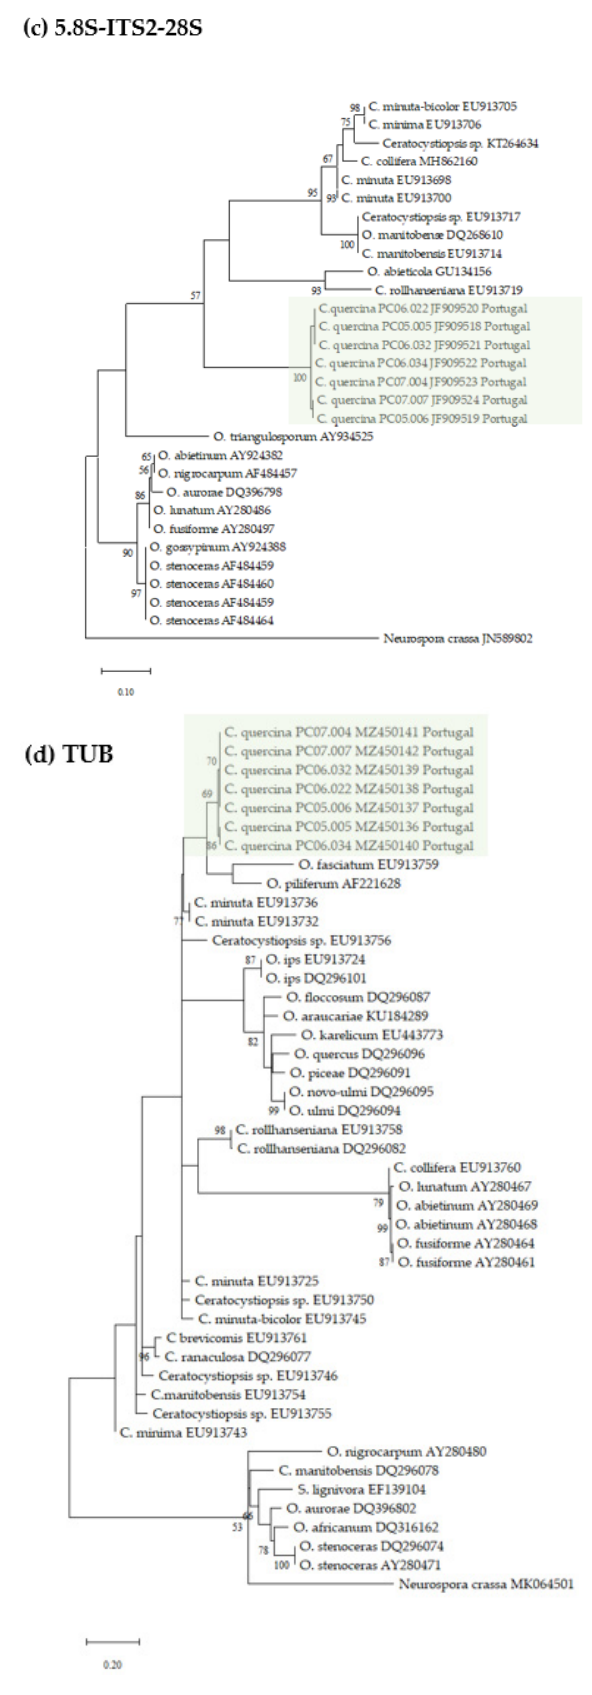
Figure 2. Phylogenetic trees resulting from maximum likelihood analyses of the ( a ) LSU, ( b ) SSU, ( c ) ITS2, and ( d ) TUB regions for species of Ophiostoma and Ceratocystiopsis. Bootstrap support val- ues above 50 are indicated on the nodes. New sequences and new species proposed in this study are indicated in color. In all the phylogenies three clades were distinctly present, i.e., one repre- sented by known isolates of Ophiostoma spp., a second one containing isolates of known Ceratocys- tiopsis spp., and a third clade with the new seven isolates from this study. The seven isolates from this study, included in all the separate analyses of the rDNA and β -Tubulin gene regions, resulted in trees with similar topologies (Figure 2). The novel fungal isolates derived from this study claded apart from all pre-existing and known clades (57–89% bootstrap support. See Figure 2).